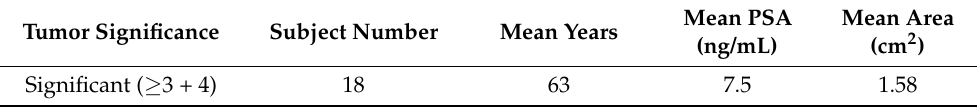
Figure 1. Flowchart of inclusion and exclusion criteria for patient selection. Table 1. The demographic data and ROIs for significant